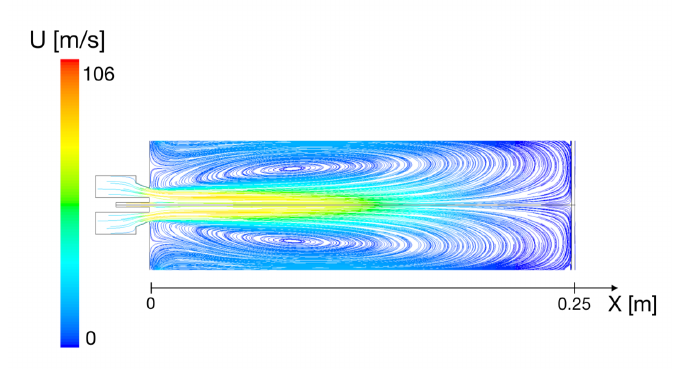
Figure 1. Velocity distribution (m/s) inside the combustion chamber. EDC-GRI2.11 numerical model.